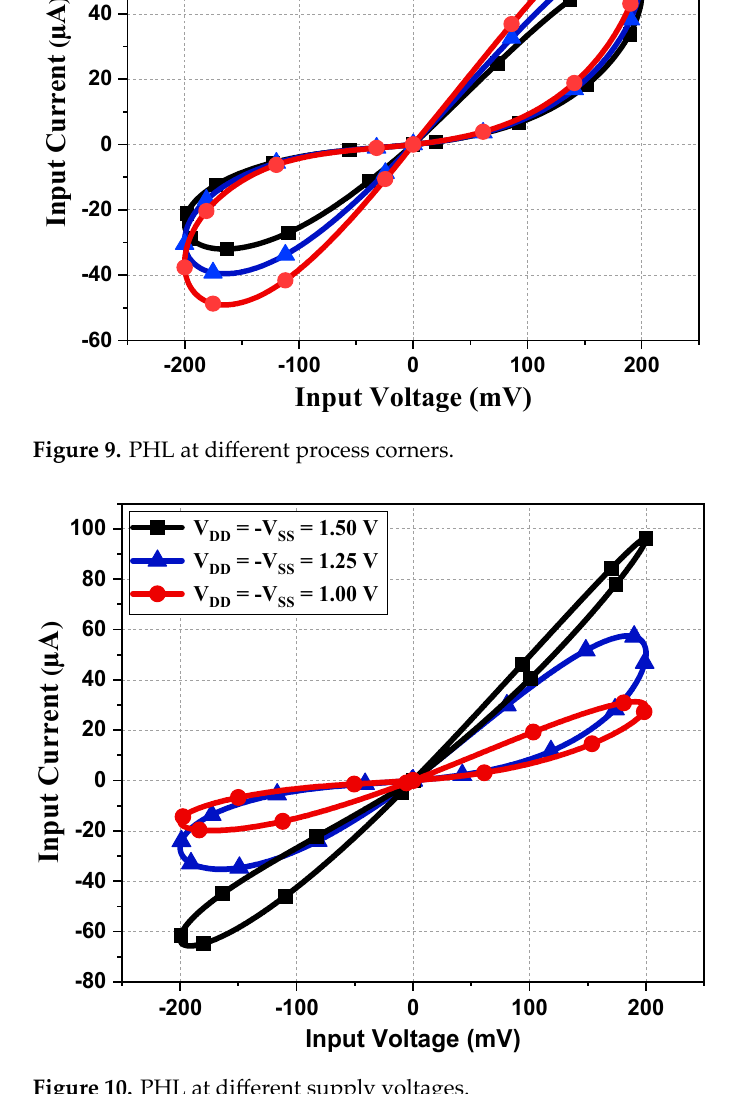
Figure 10. PHL at different supply voltages.